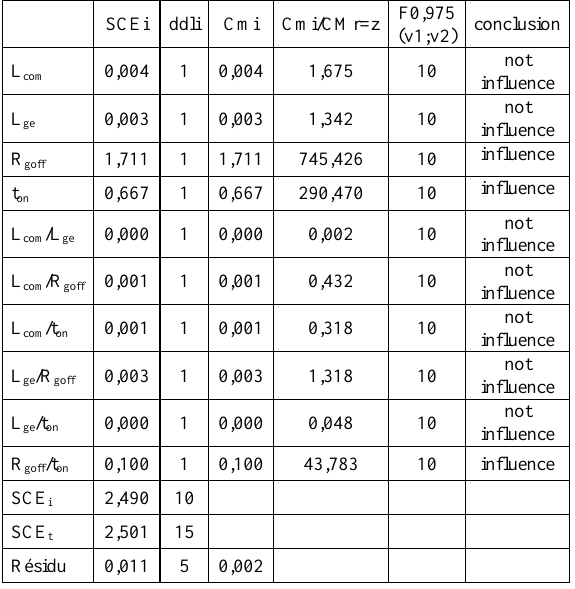
Table 5: Analyse of variance realized on dV/dt